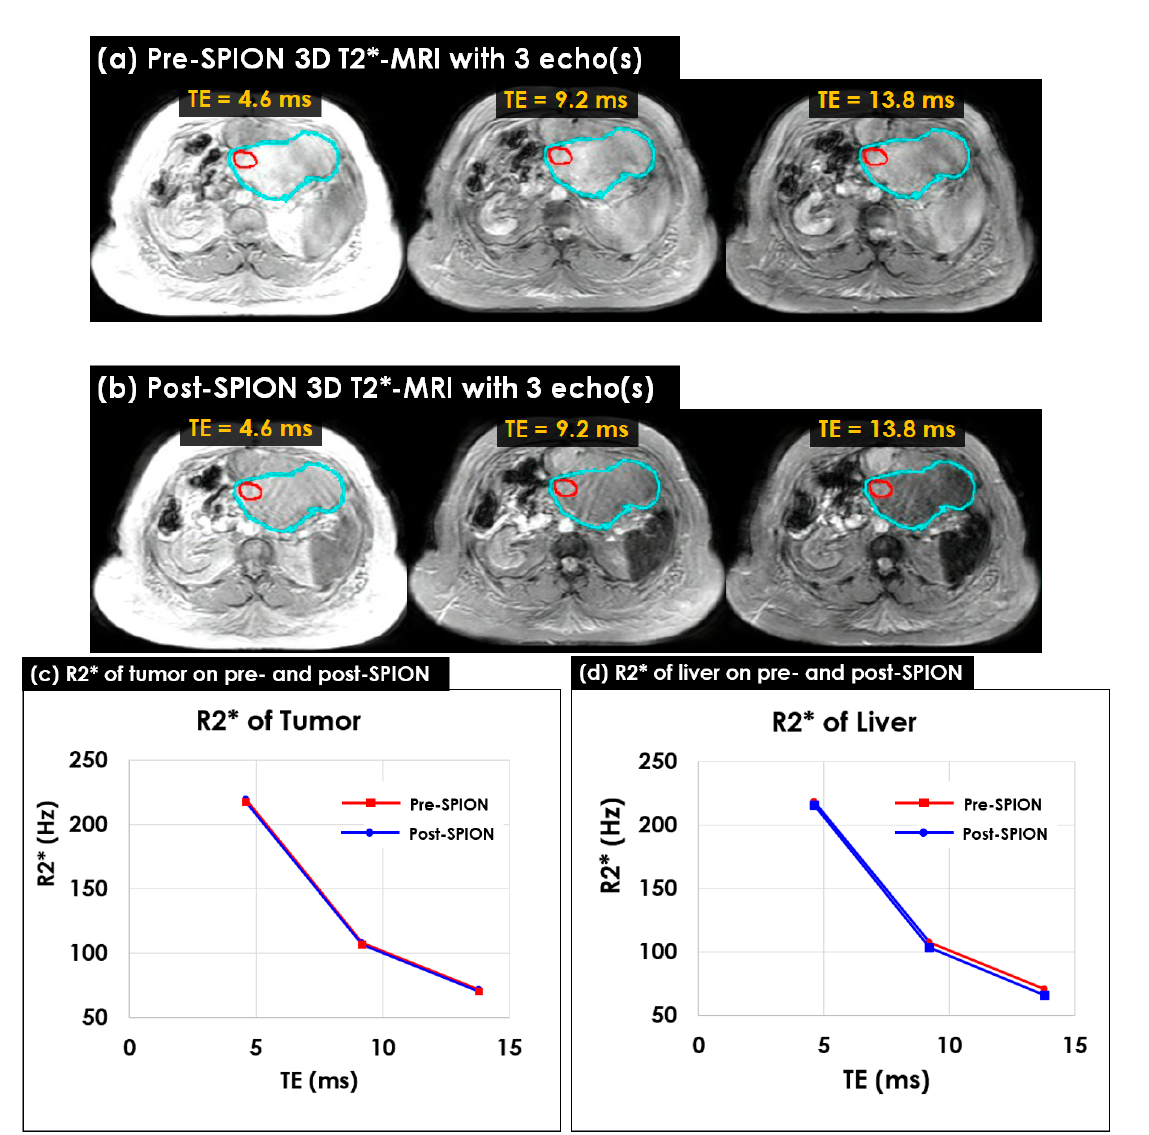
Figure 4. Pre- and post-SPION multi-echo 3D T2*-MRI and R2*-MRI in P09. ( a ) Pre- and ( b ) post- SPION 3D T2*-MRI with three echoes acquired at every 4.6 ms before and after 72 h after the SPION injection; ( c ) the R2* change in tumor between pre- (red line) and post-SPION (blue line) across three echoes, and ( d ) the R2* change in liver between pre- (red line) and post-SPION (blue line) at three echoes. An average of R2* in the two contours of tumor (red) and liver (cyan) were used to depict varying R2*(s). The R2* of the liver noticeably changed more than the R2* of the tumor, especially at TE = 13.8 ms.